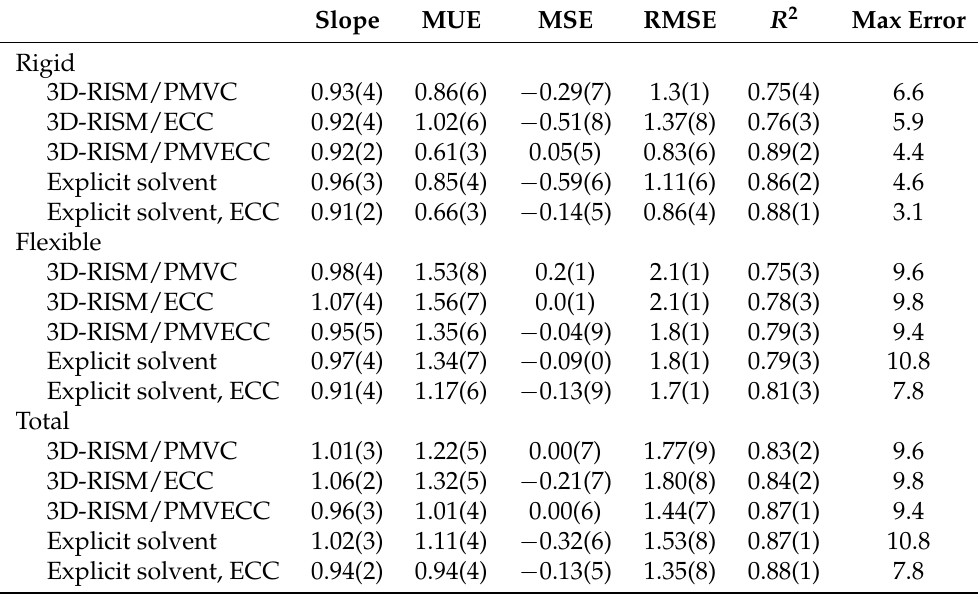
Table 2. Hydration free energies calculated with 3D-RISM and an explicit solvent [22] with PMVC, ECC, and PMVECC corrections using parameters from Table 1. Leave-out data were used to calculate statistics, except for uncorrected explicit solvent calculations, which used data from Ref. [22] with the same bootstrap procedure. All values are given in kcal/mol. Uncertainties in the last digit are given in parentheses and represent the standard error of the mean. See Section 5.5 for details of the fitting